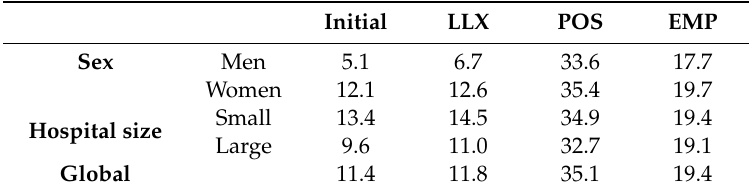
Table 1. Explained variance percentages for the leader–member exchange theory (LMX)-commitment relationship with the initial model and after the three moderating variables; global and categorised values by sex and hospital